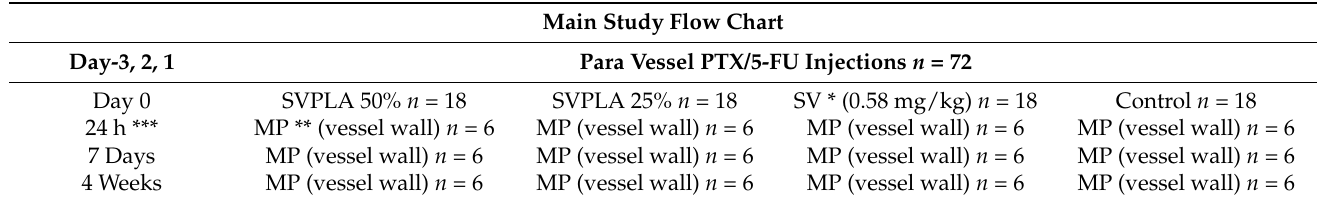
Table 4. Main study flow chart.